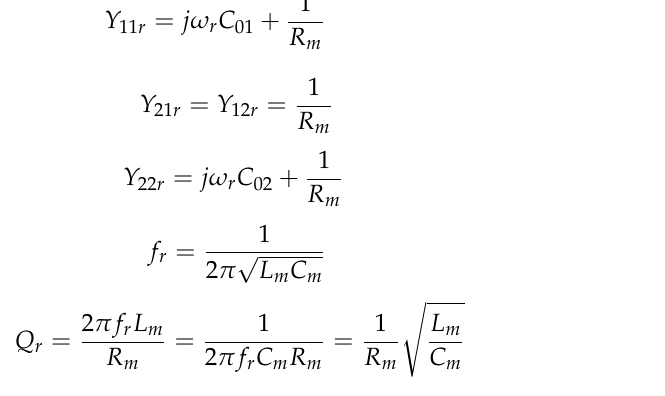
Figure 5. Lumped-element equivalent-circuit model for the investigated two-port SAW resonators.